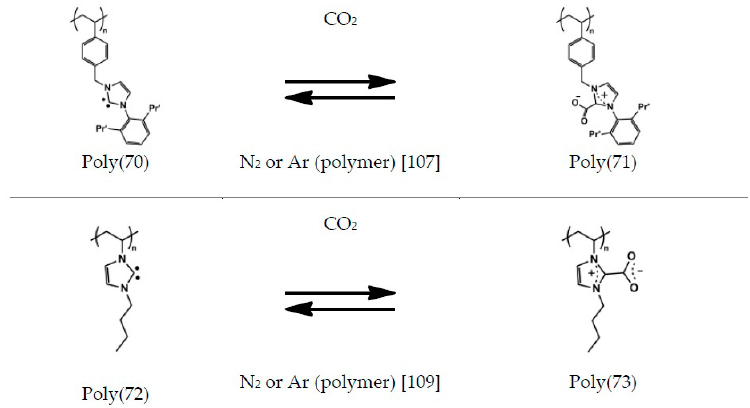
Figure 11. Switch in polymer from polyneutral to polyzwitterionic state triggered by CO 2.